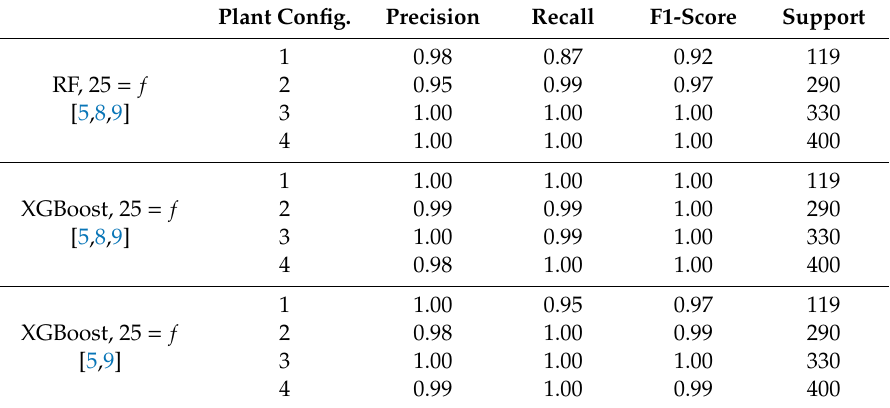
Table 8. Validation—selected environmental data for plant configuration identification. Plant Config.